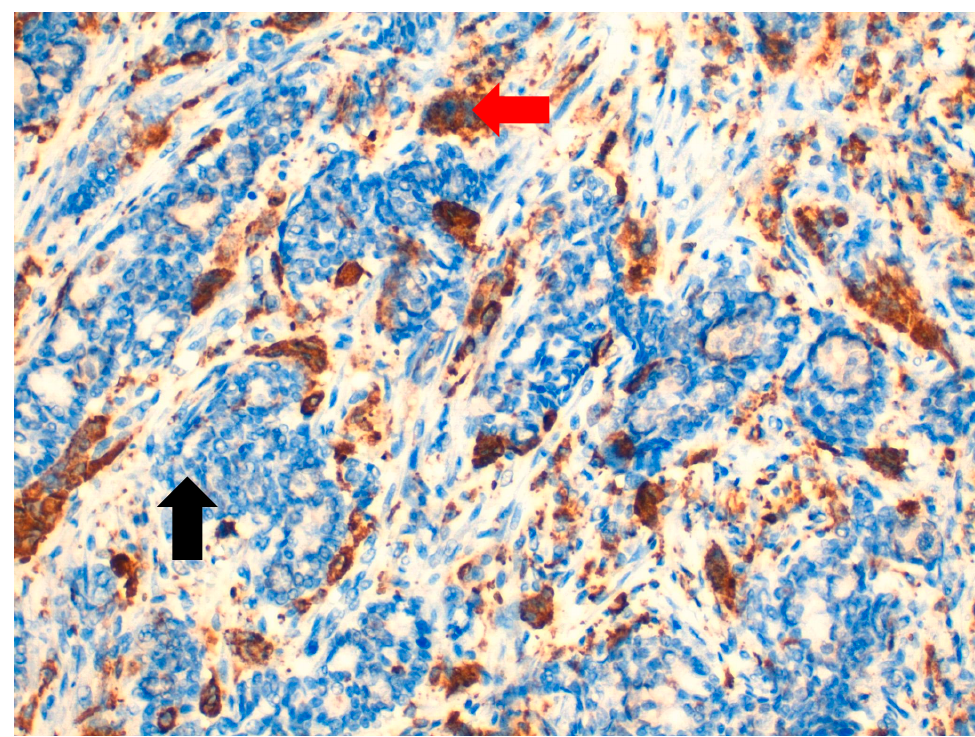
Figure 3. At 40x magnification. Immunohistochemical-positive reaction of macrophages included osteoclast-like giant cells Figure 3. At 40 × magnification. Immunohistochemical-positive reaction of macrophages included osteoclast-like giant cells Figure 2. Hematoxylin and eosin stain 20x showing invasive ductal carcinoma with at least 30 osteoclast-like giant cells (OGCs) for CD68 ( ), unlike neoplastic cells, which are CD68-negative ( ). J. Pers. Med. 2021 , 11 , 156 (OGCs) for CD68 ( Figure 4. At 40x magnification. Immunohistochemical-positive reaction of OGCs and macrophages for CD163 ( ), unlike ), unlike neoplastic cells, which are CD68-negative ( ( ↑ ), which are multinucleated cells and vary in shape and size with eosinophilic cytoplasm; grouped neoplastic cells ( ) are present immersed in the stroma containing adipocytes ( ↑ ). neoplastic cells, which are CD163-negative ( ).